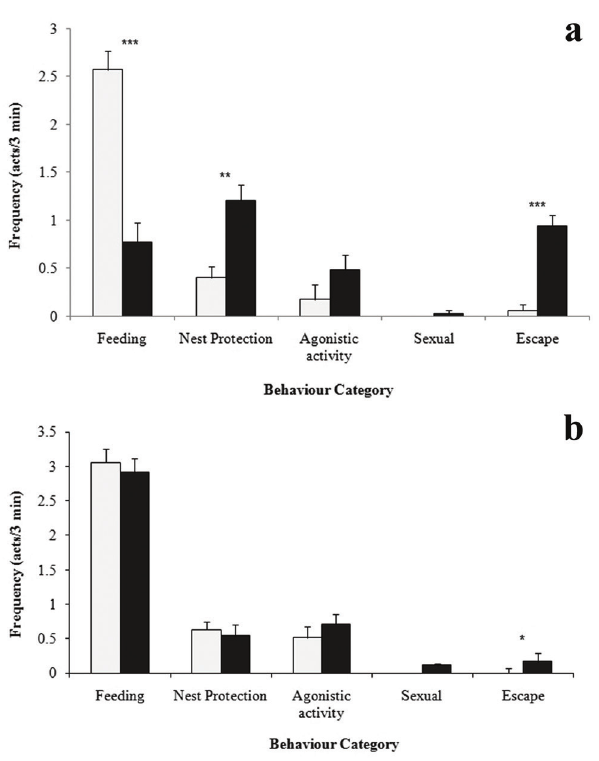
Fig. 5. Variation of behaviour patterns between No Tourism and Tourism sites for Crenicichla lepidota (mean and SEM); (a) Feeding; (b) Agonistic activity; (c) Escape behaviour. Lighter bars = No Tourism site; darker bars = Tourism site. (Mann-Whit- ney U-test). N= 35; * p < 0.05; ** p < 0.01; ***p < 0.0001.